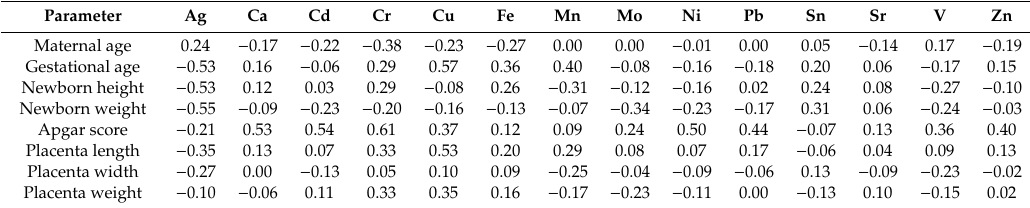
Table 11. Pearson’s coe ffi cients for correlations between biological parameters of the mother, newborn, and placenta, and the concentrations of Ca, Cd, Cr, Cu, Fe, Mn, Mo, Ni, Pb V, and Zn in the umbilical cord ( p <